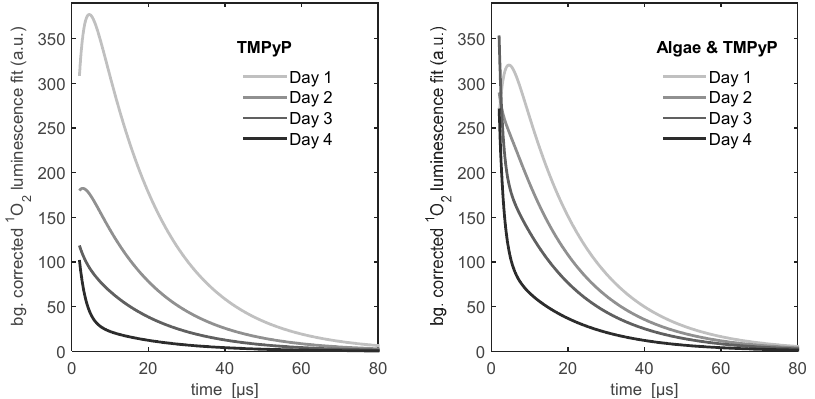
Figure 6. Temporal development of the singlet oxygen signals, measured on the surfaces of the TMPyP reference sample and the samples of TMPyP incubated in green algae over four days.